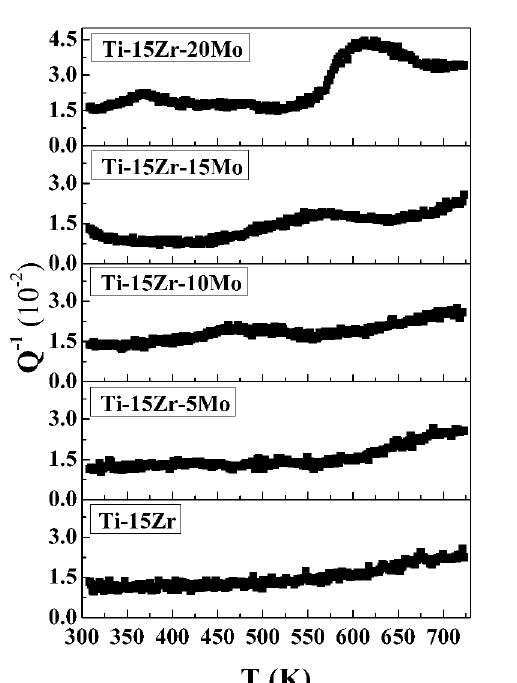
Figure 1. Internal friction as a function of temperature for the alloys of Ti-15Zr-Mo